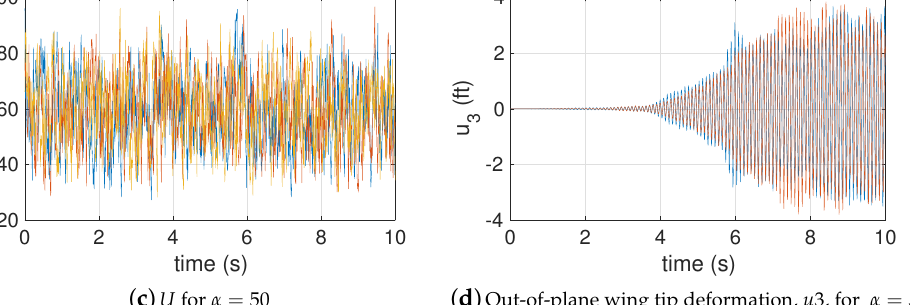
( d ) Out-of-plane wing tip deformation, u 3, for α = 50 Figure 20. Goland Wing Oscillation with correlation function, r xx = e − ατ , where U ave = 460 ft/s, and ∆ =